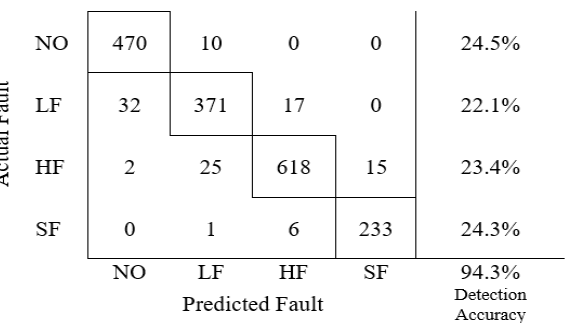
Figure 10. Output confusion matrix for the best accurate ML model, Gaussian Naïve Bayes (NB). In contrast, the CART model depends on the linkage of a different dataset and an entire exposition of the data, as explained well by Jaworski et al. [23]. When missing data were present, this model was unreliable. This observation was also valid for the RF model.